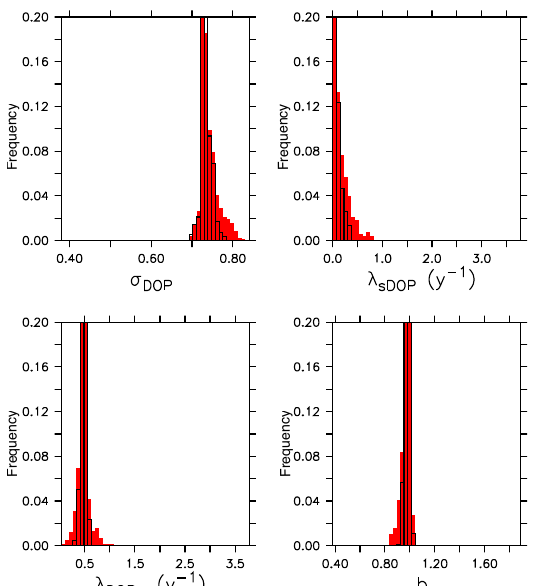
Figure 7. As in Fig. 1, but for optimisation RetroMOPS ◦